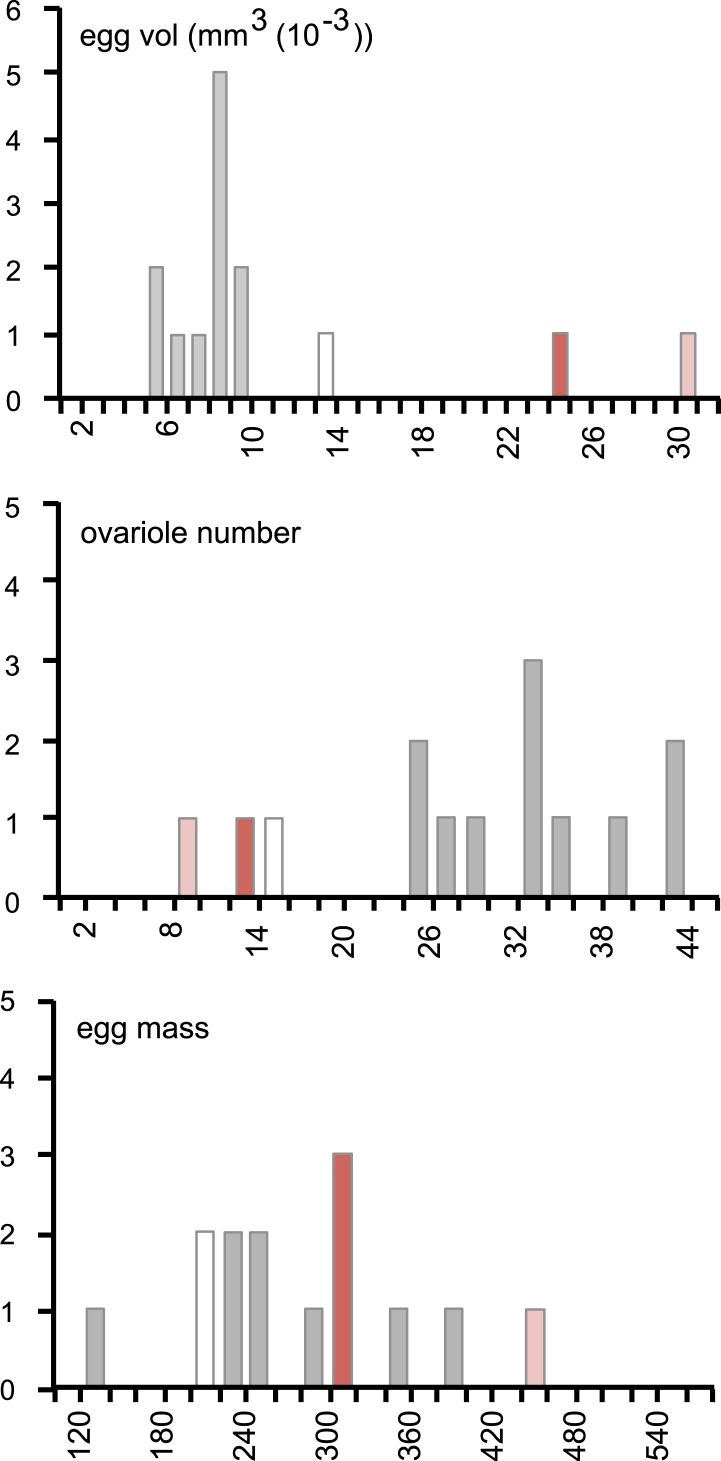
Female resource investment on fertility is conserved in D. sechellia.Histograms of egg volume (mm3 (10−3)) (top), ovariole number (middle), and egg mass production (egg mass, calculated as egg volume × ovariole number) (bottom) in D. sechellia 14021–0248.25 (red bar) and D. sechellia 14021–0248.31 (light red bar) fed a morinda diet, compared to 12 Drosophila siblings (D. ananassae (14024–0371.13), D. erecta (14021–0224.01), D. melanogaster (wild type Berlin and 14021–0231.36), D. mojavensis (15081–1352.22), D. persimilis (14011–0111.49), D. pseudoobscura (14011–0121.94), D. sechellia (14021–0248.25, white bar), D. simulans (14021–0251.195), D. virilis (15010–1051.87), D. willistoni (14030–0811.24), D. yakuba (14021–0261.01), (data from Markow et al., 2009), (grey bar)) fed a standard diet.